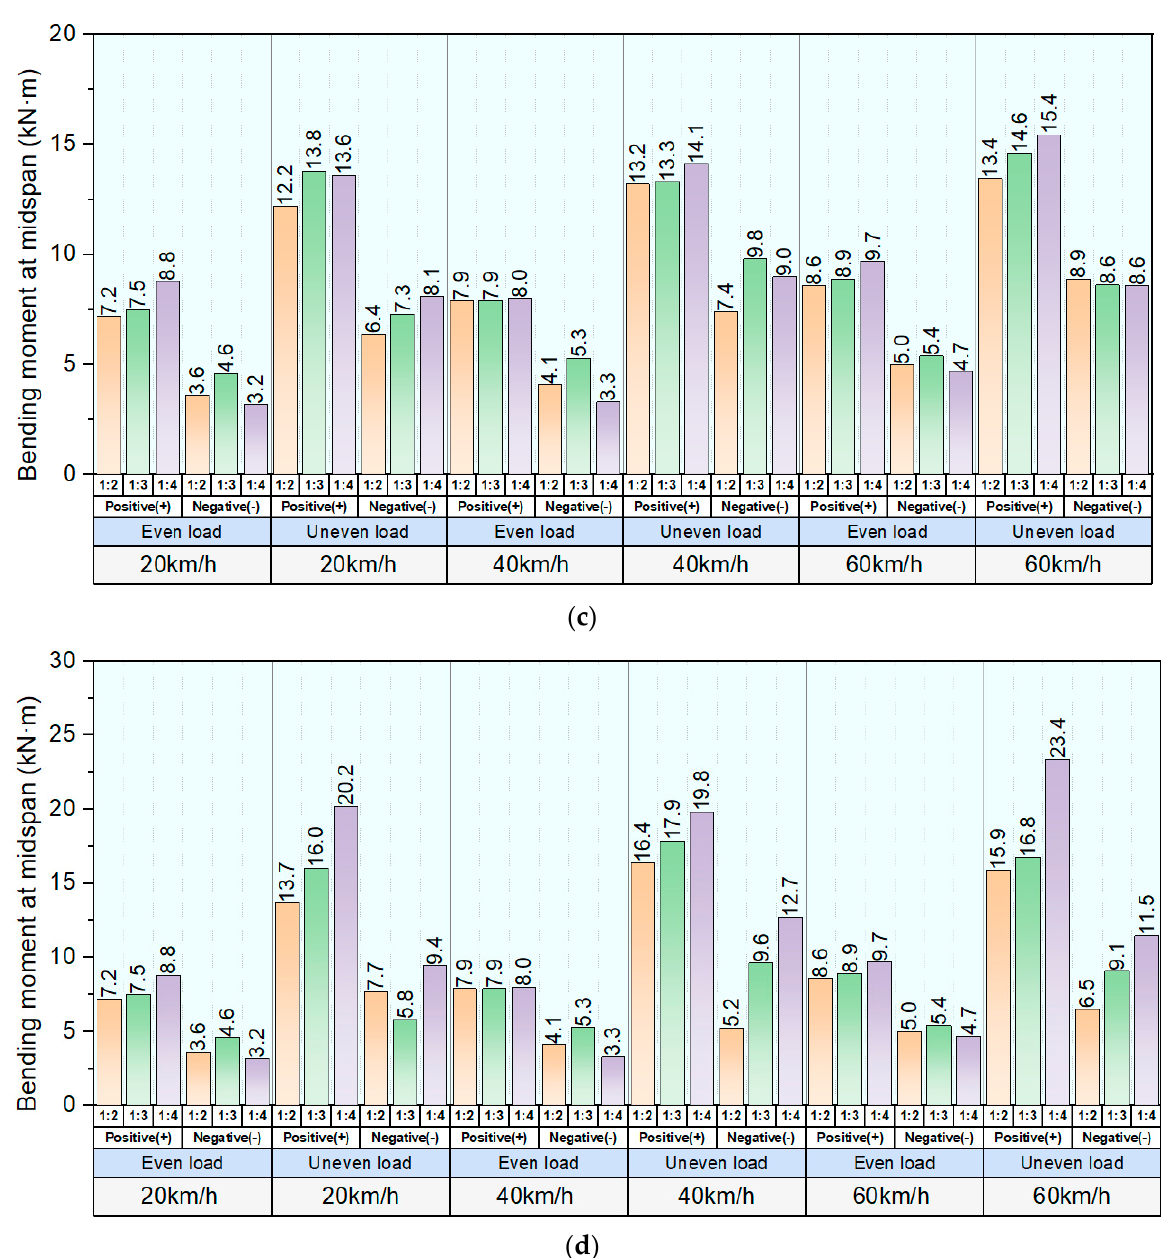
Figure 15. Maximum positive and negative bending moments of 1:2, 1:3 and 1:4 interspersed tracks at different track supporting states. ( a ) Maximum bending moments of interspersed tracks at normal support state, ( b ) Maximum bending moments of interspersed tracks at small–scale support loss state, ( c ) Maximum bending moments of interspersed tracks at large–scale support loss state and ( d ) Maximum bending moments of interspersed tracks at full–scale support loss state.